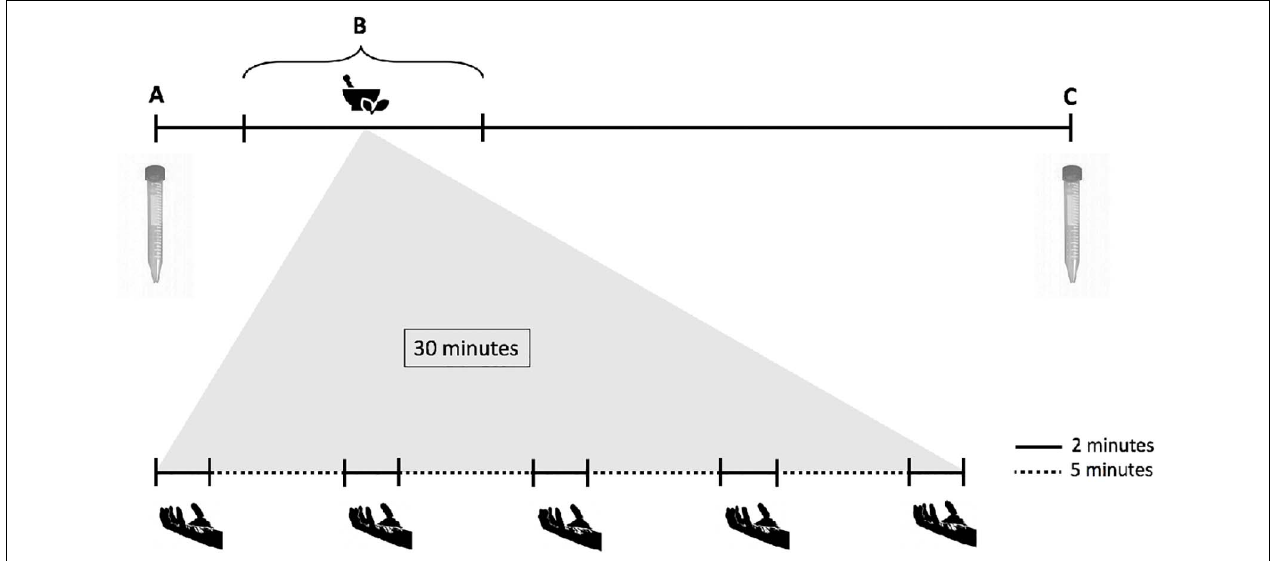
FIGURE 1 | Schematic illustration of the sampling procedure timeline. (A) Unstimulated saliva was collected from the mouth, then the rumen was partially emptied. (B) The cows were offered the controlled meal with phytogenic compounds or control. Feed boli sampling from the cardia (collection of stimulated saliva) was performed over the first 30 min of the meal, with 2 min for collection alternated with 5 min of rest. (C) Unstimulated saliva sampling, and end of the 4-h meal.